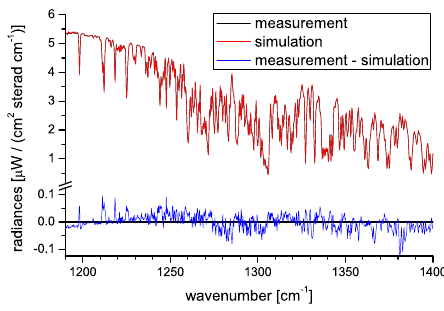
Fig. 1. Spectral region applied for the H 2 O and δ D retrieval. Black line: example of an IASI measurement; Red line: simulated IASI measurement; Blue line: residual (difference between measurement and simulation).